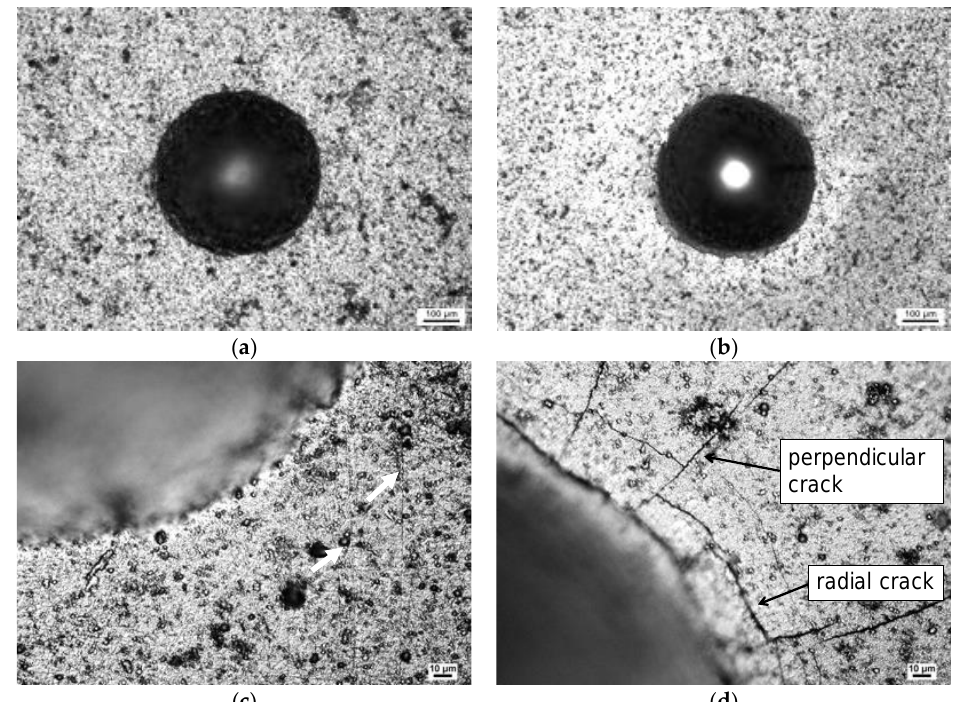
Figure 3. Rockwell-C adhesion test according to VDI 3198: ( a , c ) ta-C-coated substrate (St-C); ( b , d ) Duplex treatment (St-B-C). Arrows in ( c ) point towards cracks.